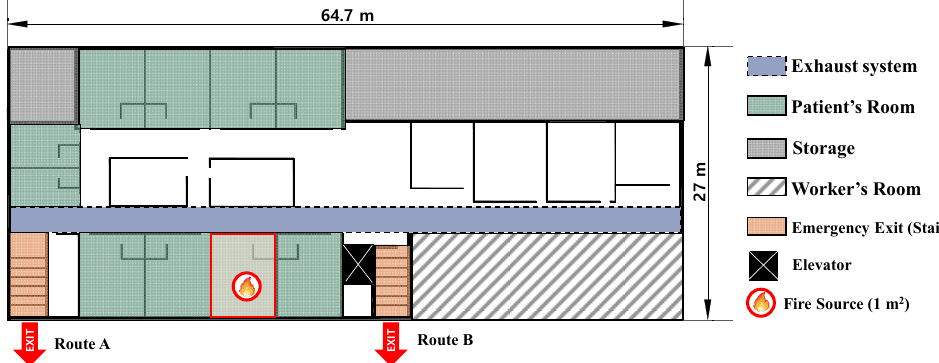
Figure 1. Floor plan and location of fire combustion and egress routes.